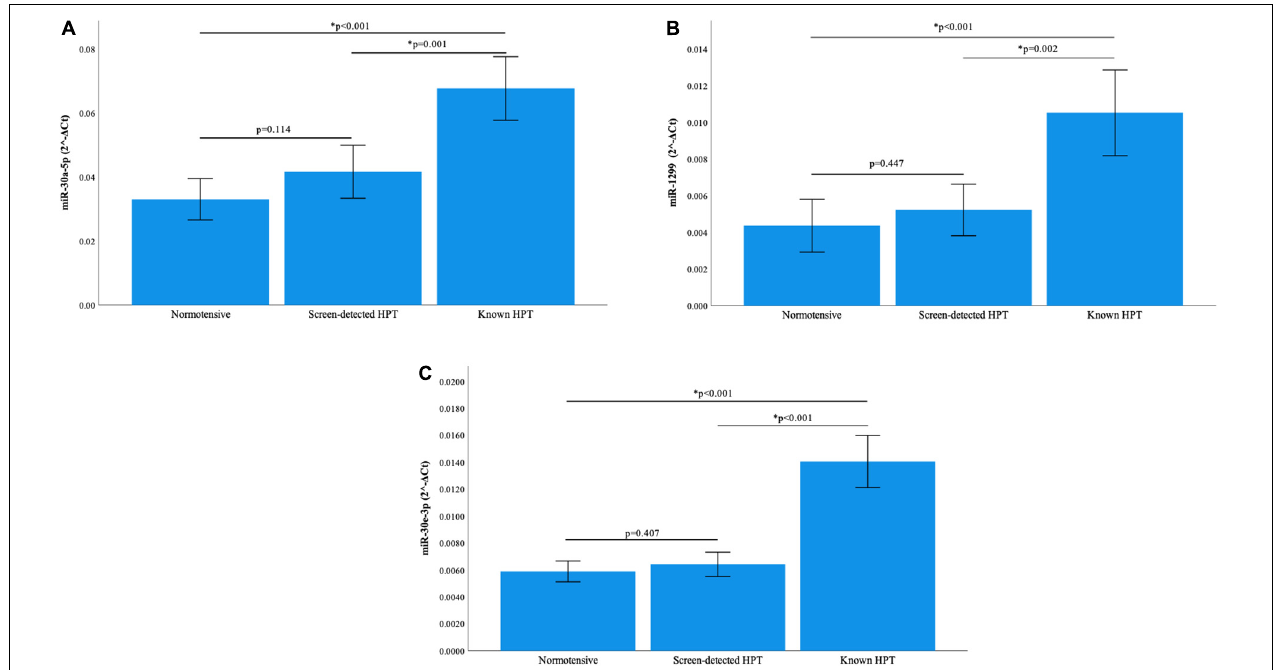
FIGURE 2 | Comparison of the relative expression of miR-30a-5p, miR-1299 and miR-30e-3p. (A) The expression of the miR-30a-5p was significantly higher in known hypertension compared to screen-detected hypertension ( p = 0.001) and the normotensives ( p < 0.001). However, there was no significant difference in expression between screen-detected hypertensives and normotensives ( p = 0.114). (B) There was a significantly higher expression of miR-1299 in known hypertension when compared to screen-detected hypertension ( p = 0.002) and the normotensives ( p < 0.001). There was no significant difference in expression when screen-detected hypertensives were compared to the normotensives ( p = 0.447). (C) The expression of miR-30e-3p was significantly higher in known hypertension when compared to screen-detected hypertension ( p < 0.001) and the normotensives ( p < 0.001). There was no significant difference in expression when screen-detected hypertensives were compared to the normotensives ( p = 0.407). The relative miRNA expressions were calculated using the 2 – (cid:49) Ct method and a one-way ANOVA used to compare differences in miRNA expression between groups. The symbol * denotes a statistically significant p